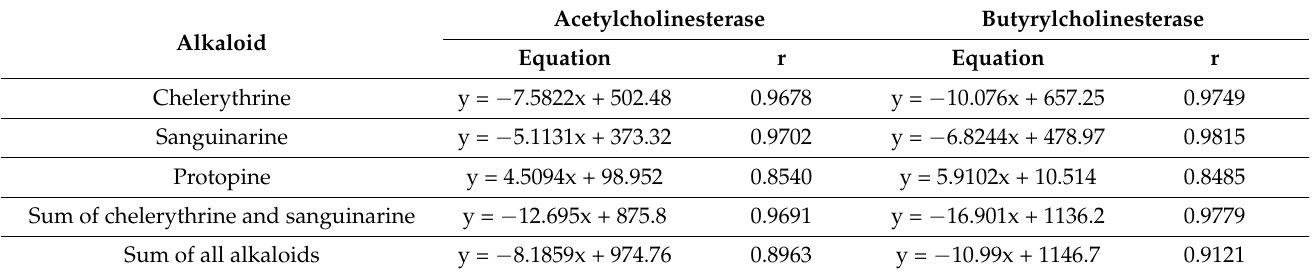
Figure 4. Correlation between the sum of chelerythrine and sanguinarine contents and butyryl- cholinesterase activity inhibition as IC 50 of the investigated plant extracts. Table 5. Equations of correlation curves and Pearson correlation coefficients (r), values of isoquinoline alkaloid contents and cholinesterase activity inhibition expressed as IC 50 ( µ g/mL) of the investigated plant